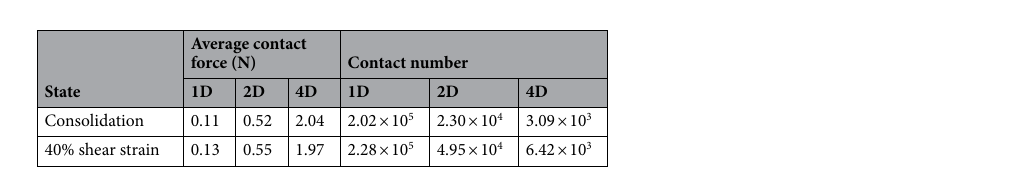
Table 4. Summary of the distribution of contact